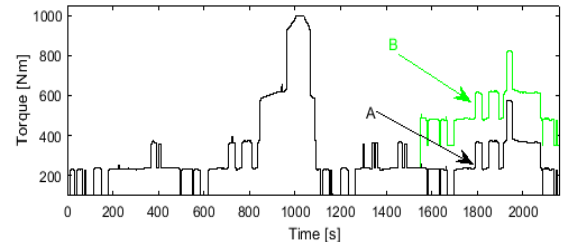
Figure 13. Engine torque A) Without generator, B) With generator